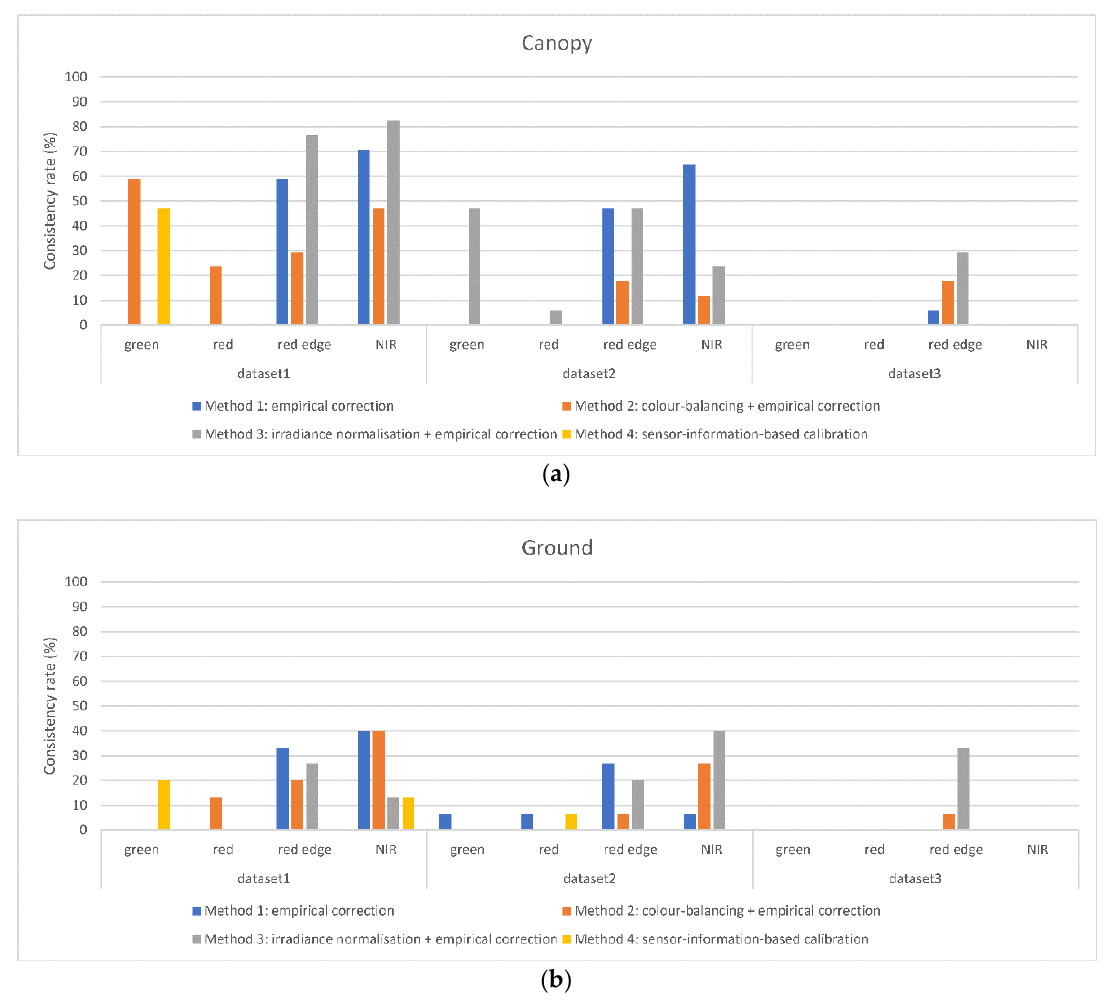
Figure 6. Consistency rate derived from box-and-whisker comparison for ( a ) canopy areas and ( b ) ground patches of avocado datasets. It only shows the lowest consistency rates among the three datasets because box-and-whisker comparison was only applicable to two datasets at a time. It shows that no method provided overall robust correction, while the consistency in the red edge and NIR bands is generally higher than in the green and red bands.